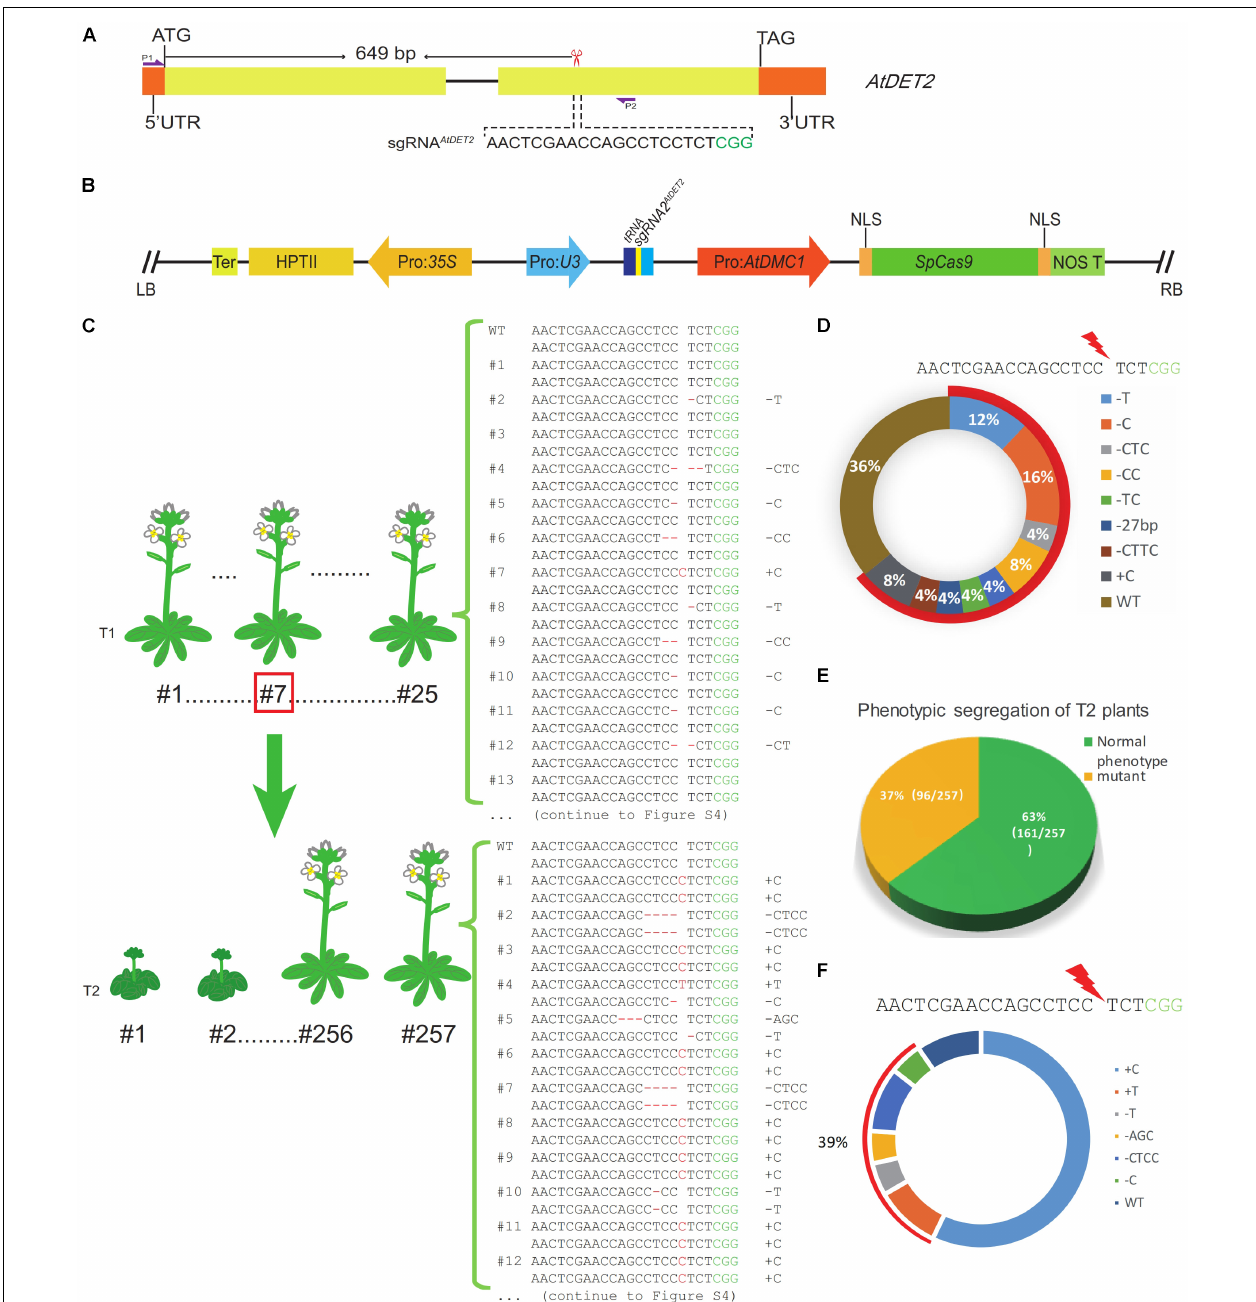
FIGURE 1 | Efficient targeted mutagenesis for the AtDET2 gene edited by the MSC system in Arabidopsis. (A) The genomic targeted site in the AtDET2 gene. The sgRNA AtDET2 sequence is shown in black and the green sequence is the PAM (protospacer adjacent motif). The red scissor indicates the position of the targeted site. P1 and P2: a pair of specific primers for amplifying the DNA fragment that covers the target site. (B) A structural representation of the pLFC286 plasmid, showing the SpCas9 endonuclease driven by Pro: AtDMC1 ; and the sgRNA AtDET2 driven by the Pol-III promoter U3 . LB/RB, T-DNA left/right border; NOS T, nos gene terminator; HPTII, hygromycin-resistance gene; Ter, terminator. (C) Genotyping results of Atdet2 mutants generated by the MSC system in the T1 and T2 generations. The relationship between generations was shown in the panel. 25 T1 transgenic lines and 23 T2 lines were sequenced. The genotypes were listed on the right. (D) Genotypes and their relative frequency of T1 transgenic plants. Aligning with the wild-type sequence, 36% plants with no change in sequence. However, 64% plants are heterozygous. The 20 bp black sequence is sgRNA AtDET2 and the green sequence is PAM, red lightning symbol represents the DSB formation site. (E) Phenotypic segregation analysis for the T2 plants. Plants with a normal like phenotype account for 63% (161/257). Plants displaying Atdet2 mutant phenotypes occupy 37% (96/257). (F) Genotypes and their relative frequency of T2 plants. Aligning with the wild-type sequence, 39% targeted mutations are de novo mutations that aren’t inherited from parental plant. 9% plants were no change in sequence and the genotype with 1 bp C insertion (+C) account for 52%, which are mostly inherited from the parental plant #7. The black sequence is sgRNA AtDET2 and the green letter is PAM.